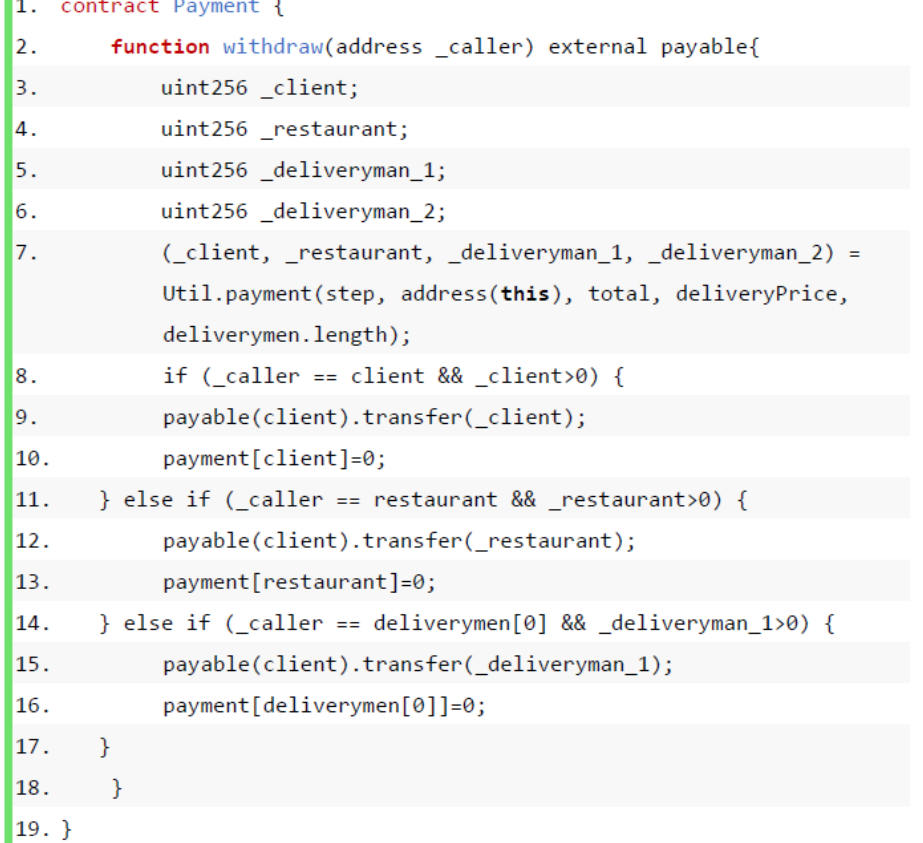
Figure 15. The payment contract withdraws the Token in the smart contract.